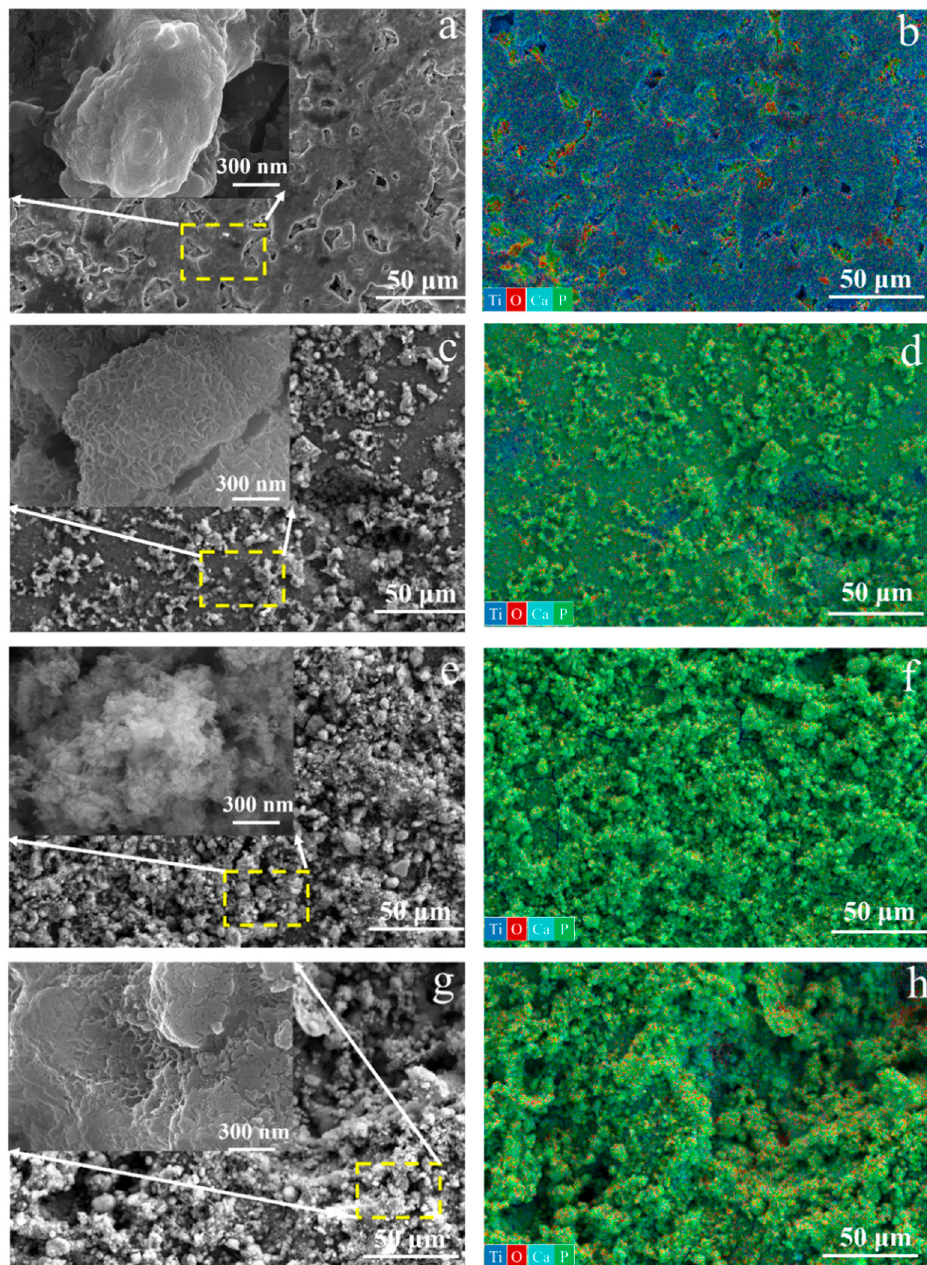
Figure 9. The surface morphology of porous titanium mineralized for 14 days after different con- centrations of NaOH treatment. ( a ) Untreated porous Ti, ( b ) EDS diagram of untreated porous Ti, ( c ) 5 M NaOH-treated porous Ti, ( d ) EDS diagram of 5 M NaOH-treated porous Ti, ( e ) 10 M NaOH- treated porous Ti, ( f ) EDS diagram of 10 M NaOH-treated porous Ti, ( g ) 15 M NaOH-treated porous Ti, ( h ) EDS diagram of 15 M NaOH-treated porous Ti.